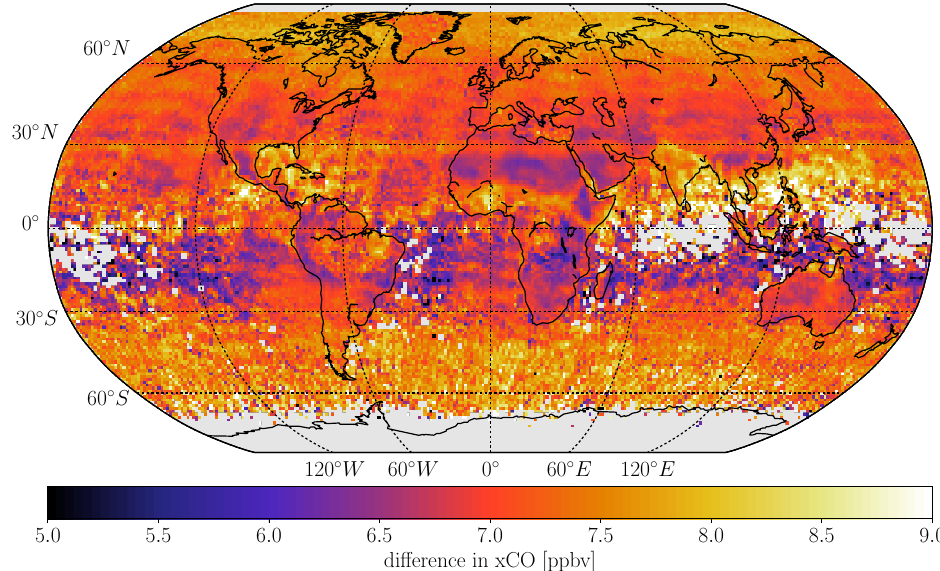
Figure 7. Spatial distribution of differences in CO mole fractions between SEOM and HITRAN2016 for the April–June 2004 time period. Gray pixels indicate areas where no retrievals were left after